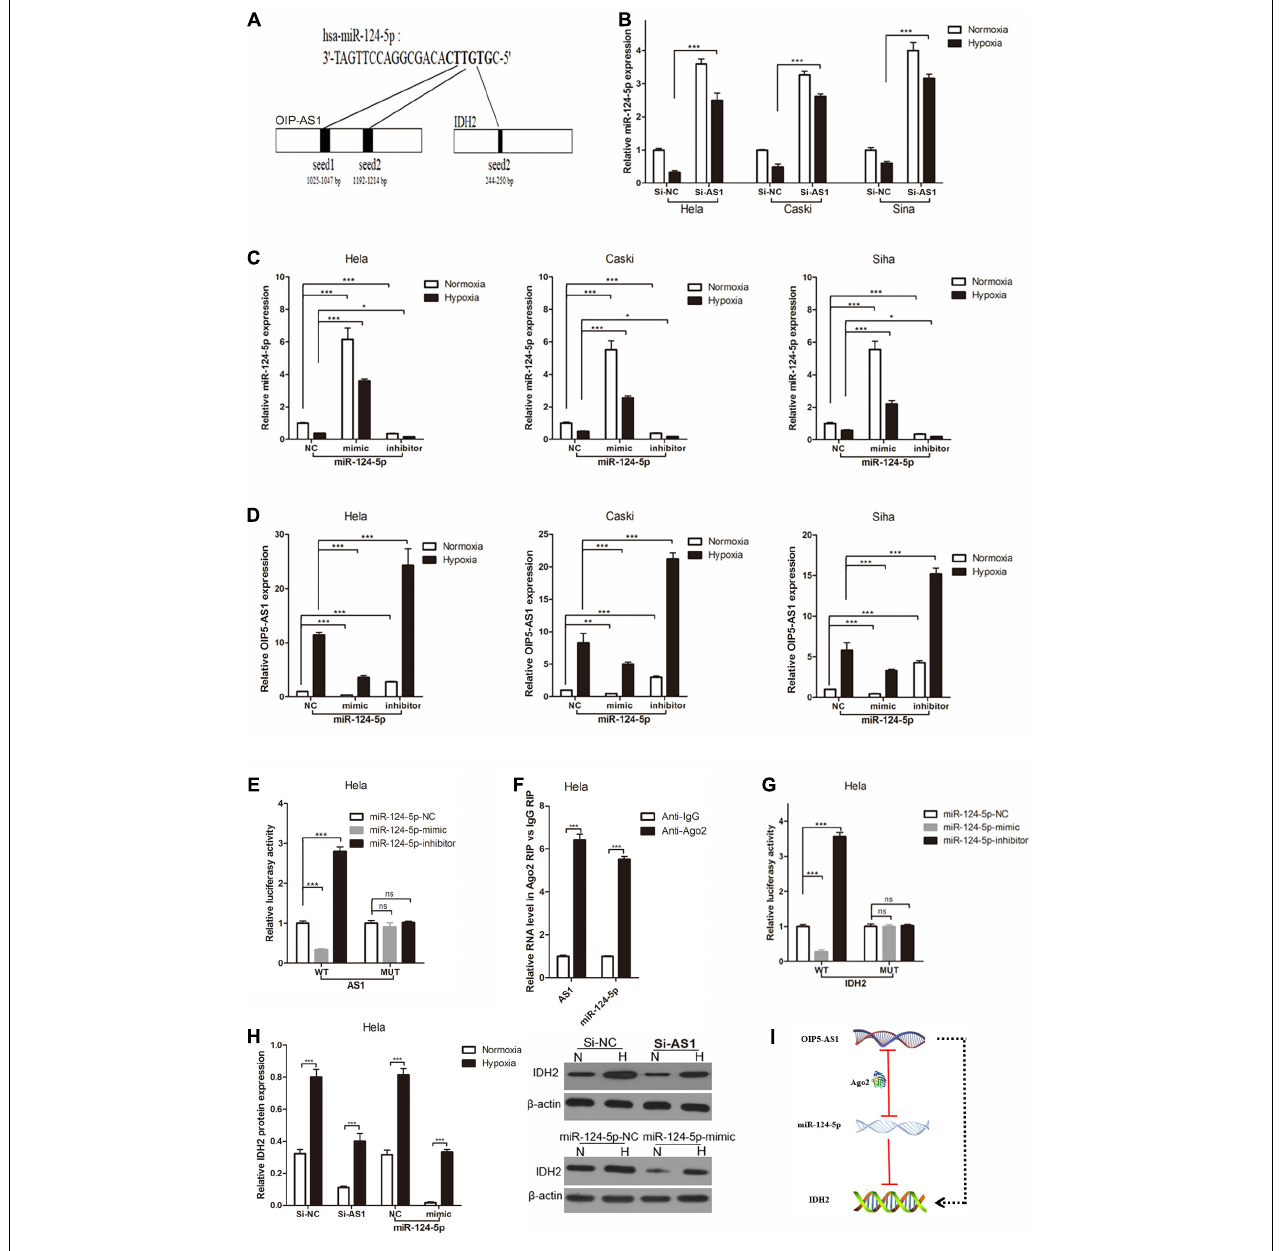
FIGURE 6 | OIP5-AS1 regulates miR-124-5p expression by both directly targeting and Ago2-dependent manner, and miR-124-5p target inhibition of IDH2 expression in cervical cancer cell. (A) Predicted binding sites of miR-124-5p on OIP5-AS1 transcript (black) and IDH2 transcript (black). (B) RT-qPCR analysis of the indicated miR-124-5p levels in Hela, Caski, and Siha cells under normoxic or hypoxic conditions for 24 h. Data were shown as mean ± SD of three individual experiments. *** was P < 0.001 and P value was calculated by Student’s t test. (C,D) RT-qPCR analysis of the indicated miR-124-5p or OIP5-AS1 levels in Hela, Caski, and Siha cells over-expressing miR-124-5p or expressing knockdown miR-124-5p under normoxic or hypoxic conditions for 24 h. Data were shown as mean ± SD of three individual experiments. * was P < 0.05, ** was P < 0.01 and, *** was P < 0.001, and P value was calculated by Student’s t test. (E) miR-124-5p-NC, mimic and inhibitor was co-transferred with OIP5-AS1 wild type (WT) or mutant (MUT) transcript, and then detected luciferase activity. Data were shown as mean ± SD of three individual experiments. ns was P > 0.05 and *** was P < 0.001, and P value was calculated by post hoc comparisons. (F) RT-qPCR analysis of the indicated miR-124-5p and OIP5-AS1 levels associated with AGO2 after RIP assay in Hela cells. Data were shown as mean ± SD of three individual experiments. *** was P < 0.001, and P value was calculated by post hoc comparisons. (G,H) Dual-luciferase reporter assay shows that miR-124-5p targets inhibition of IDH2 expression (G) , and Western blot analysis shows that OIP5-AS1 promotes IDH2 expression via inhibiting miR-124-5p expression (H) . Data were shown as mean ± SD of three individual experiments. ns was P > 0.05 and *** was P < 0.001, and P value was calculated by post hoc comparisons in panel (G) and by Student’s t test in panel (H) . (I) Schematic illustration of the proposed model depicting OIP5-AS1 promotes IDH2 expression via inhibiting miR-124-5p expression.